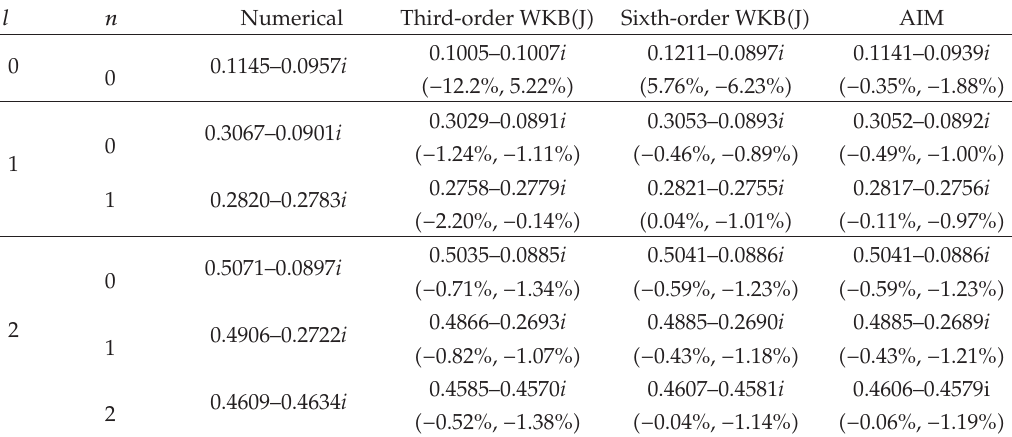
Table 8: The QNM frequencies for the Scalar Perturbations of the Kerr Black Hole, with a (cid:8) 0 . 80 (cid:2) M (cid:8) 1, m (cid:8) 0 (cid:3) . Numerical data via the CFM taken from (cid:5) 45, 46 (cid:6) , where the AIM was set to run at 15